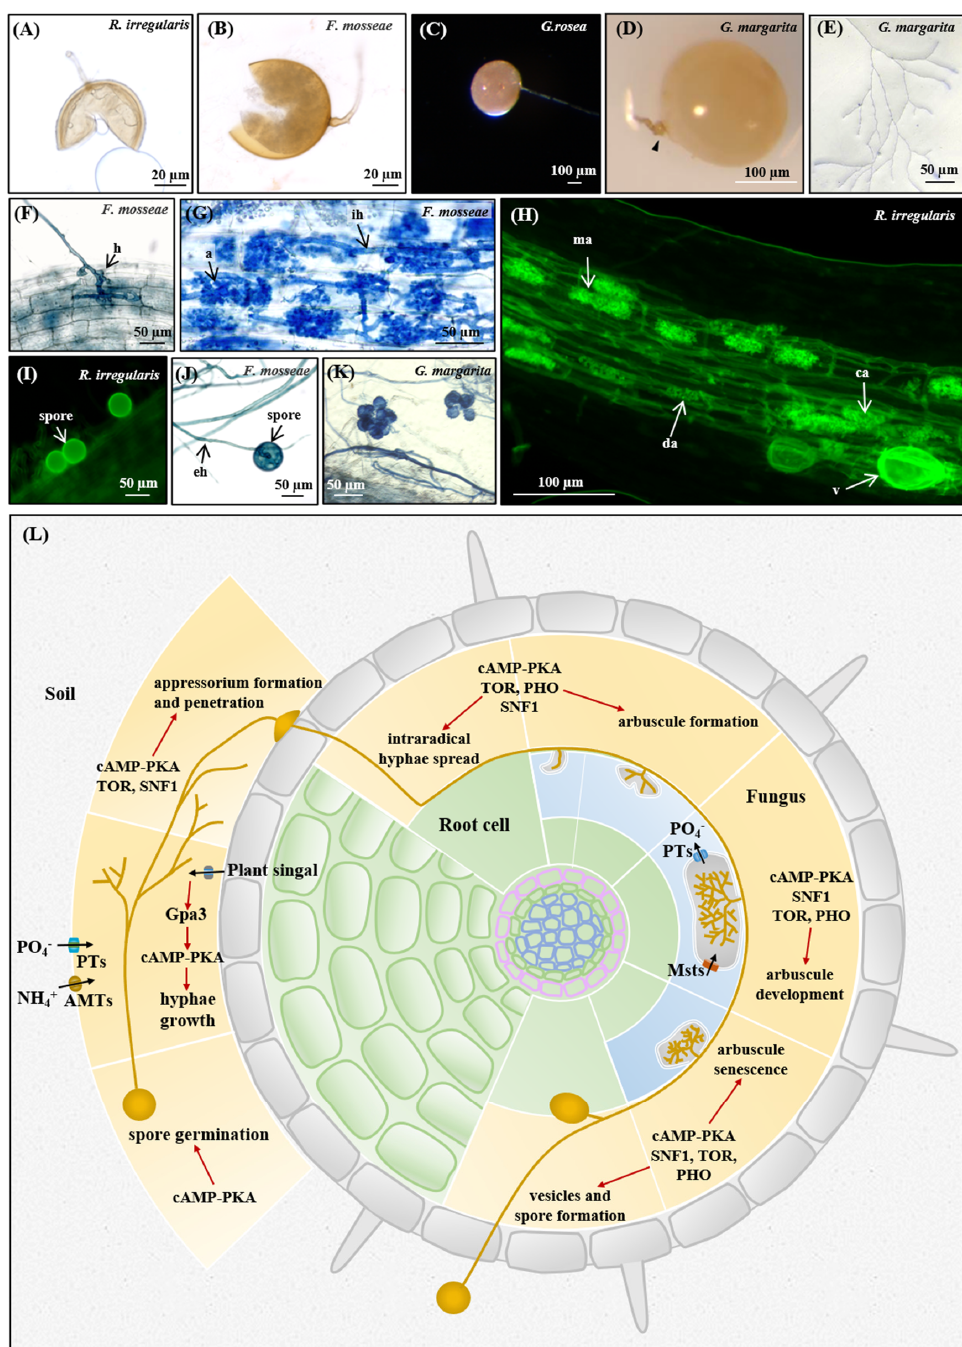
Figure 7. Potential functions of nutrient sensing and signaling pathways in the life cycle of AM fungi. The spores of R. irregularis ( A ), F. mosseae ( B ), G. rosea ( C ) and G. margarita ( D ). The branching hyphae of G. margarita ( E ). The hyphopodium of F. mosseae ( F ). The arbuscules of F. mosseae ( G ) and R. irregularis ( H ). The offspring spores of R. irregularis ( I ) and F. mosseae ( J ). The auxiliary cells of G. margarita ( K ). h, hyphopodium; a, arbuscule; ma, mature arbuscule; ca, collapsed arbuscule; de, dead arbuscule; ih, intraradical hyphae; eh, extraradical hyphae; v, vesicle. The pattern diagram ( L ) shows that the cAMP-PKA, SNF1, TOR and PHO pathways may regulate the spore germination, hyphal growth, appressorium formation and penetration, nutrients exchange and homeostasis, formation of vesicles (in Glomeromycotina fungi, except for the Gigasporales) or auxiliary cells (in Gigasporaceae fungi) and sporulation of AM fungi, as well as the development, senescence and life span of arbuscules. The black arrows represent translocation of transformation, while the red arrows represent positive